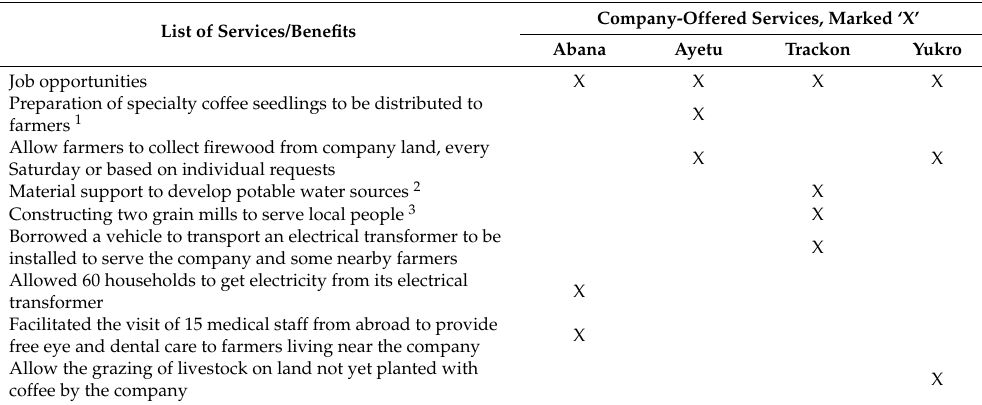
Table 3. Summary of services offered by private companies to farmers, Gera, October 2013. List of